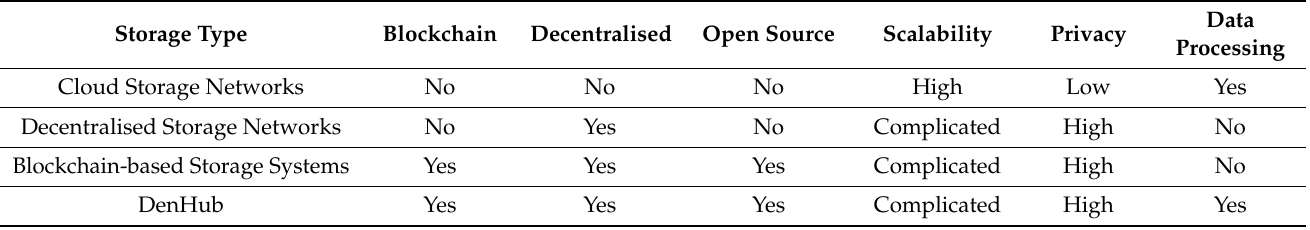
Table 4. The DenHub Storage